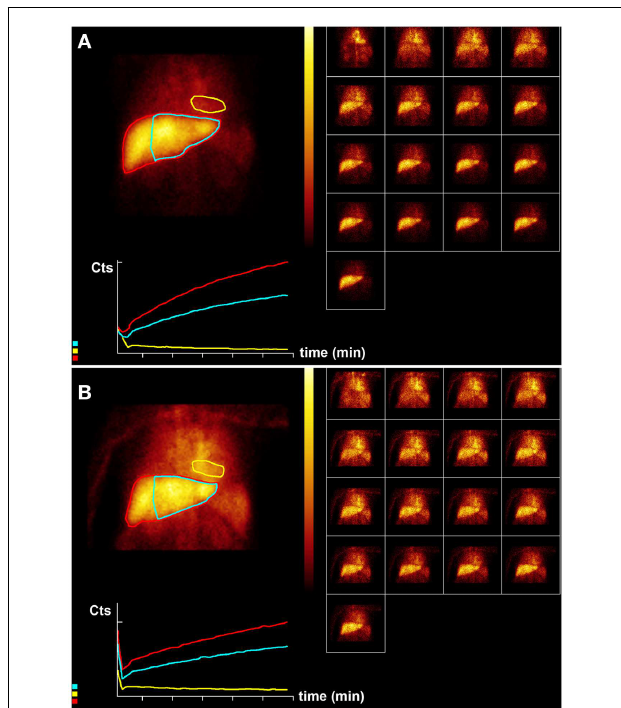
FIGURE 4 | Hepatobiliary scintigraphy before (A) and 6weeks after (B) right-sided treatment with 1.8GBq 90 Y labeled SIR-Spheres in a 64-year-old male patient with multifocal exclusively right-sided hepatocellular carcinoma with portal vein invasion . Displayed are summed dynamic frames (2 × 10s/frame), a summed image (20 × 10s) with regions of interest drawn around the entire liver (red), left liver segments 2–4 (blue), and cardiac blood pool (yellow), and corresponding time–activity curves.The total liver function (body surface area corrected mebrofenin uptake rate) was reduced after treatment from 8.5 to 6.9%/min (red curves). However, function of left liver lobes 2–4 remained unchanged 4.8%/min (blue).This functional increase is only relative and can be explained by lack of functional hypertrophy in the presence of sufficient post treatment functional liver